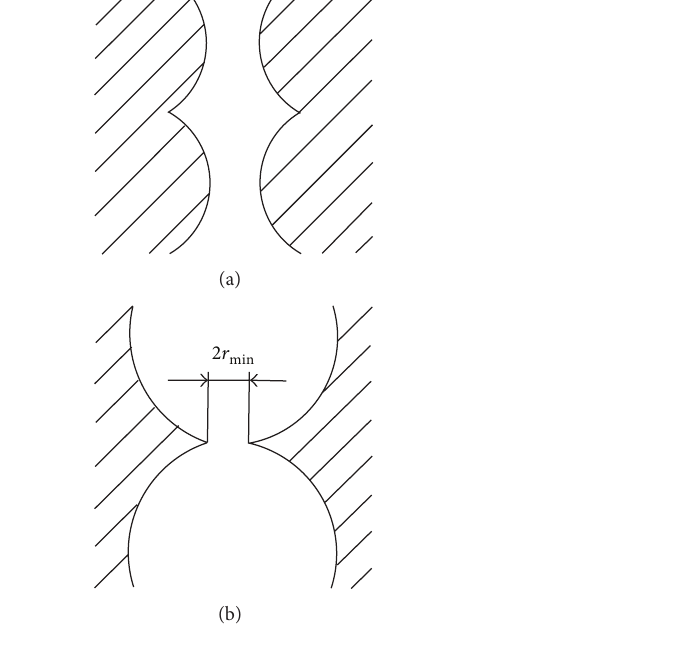
Figure 1: The shape of pores obtained by (a) metal sintering and (b) replication casting hatching area depicts